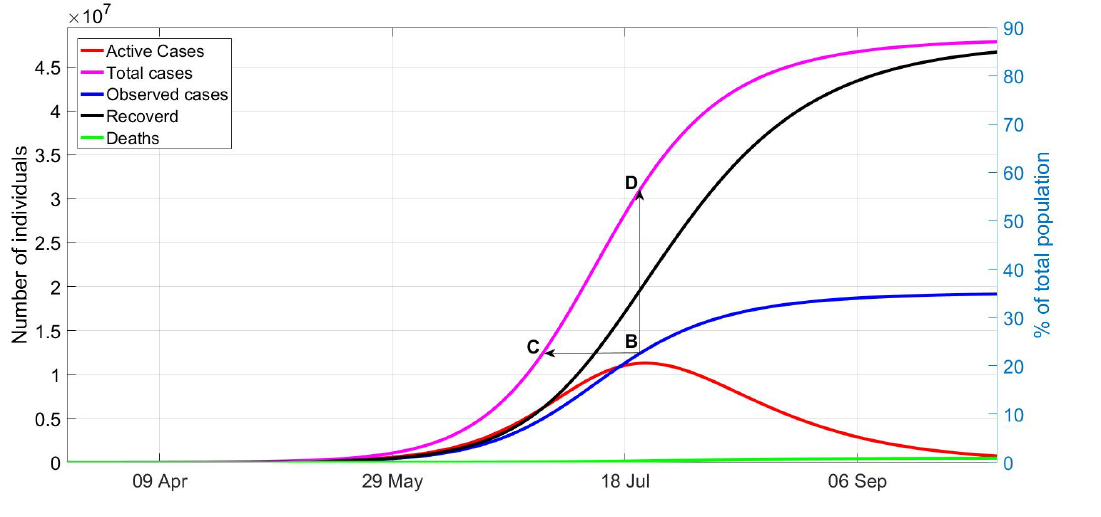
Fig. 2. Typical progression of the infection, without